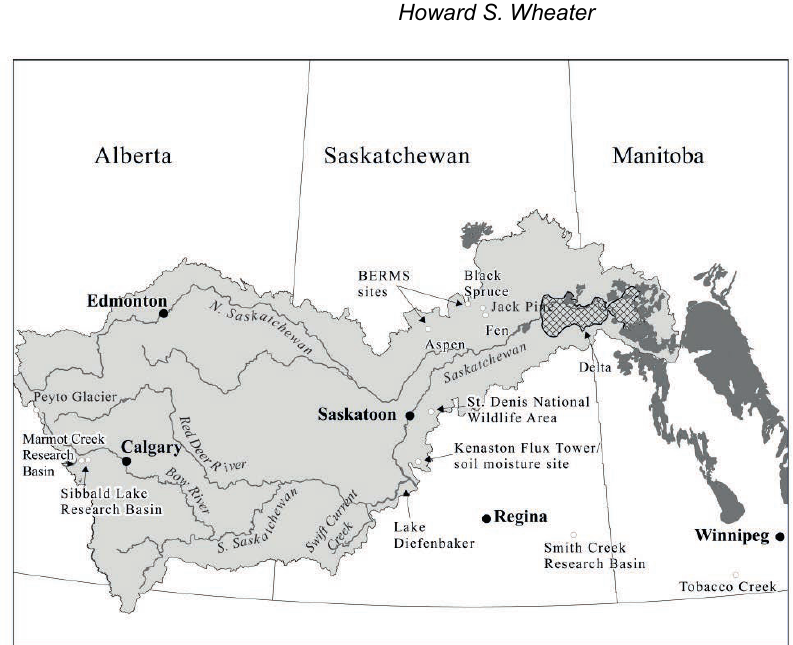
Fig. 1 Saskatchewan River Basin (SaskRB) and research